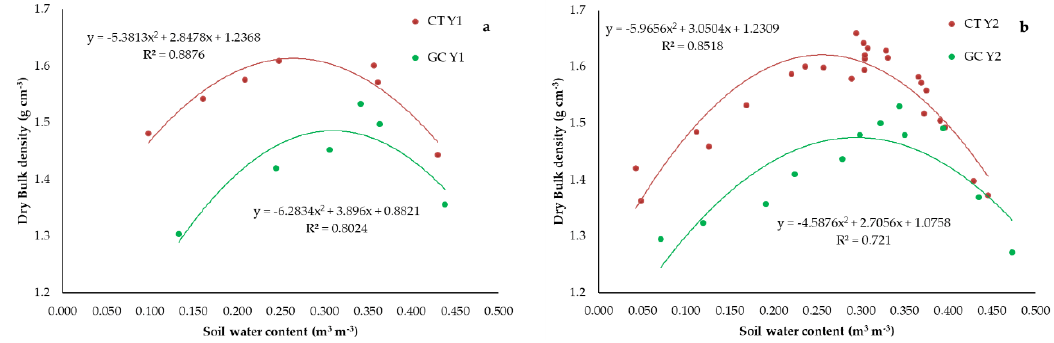
Figure 3. Standard Proctor compaction test: Year 1 ( a ) and Year 2 ( b ).